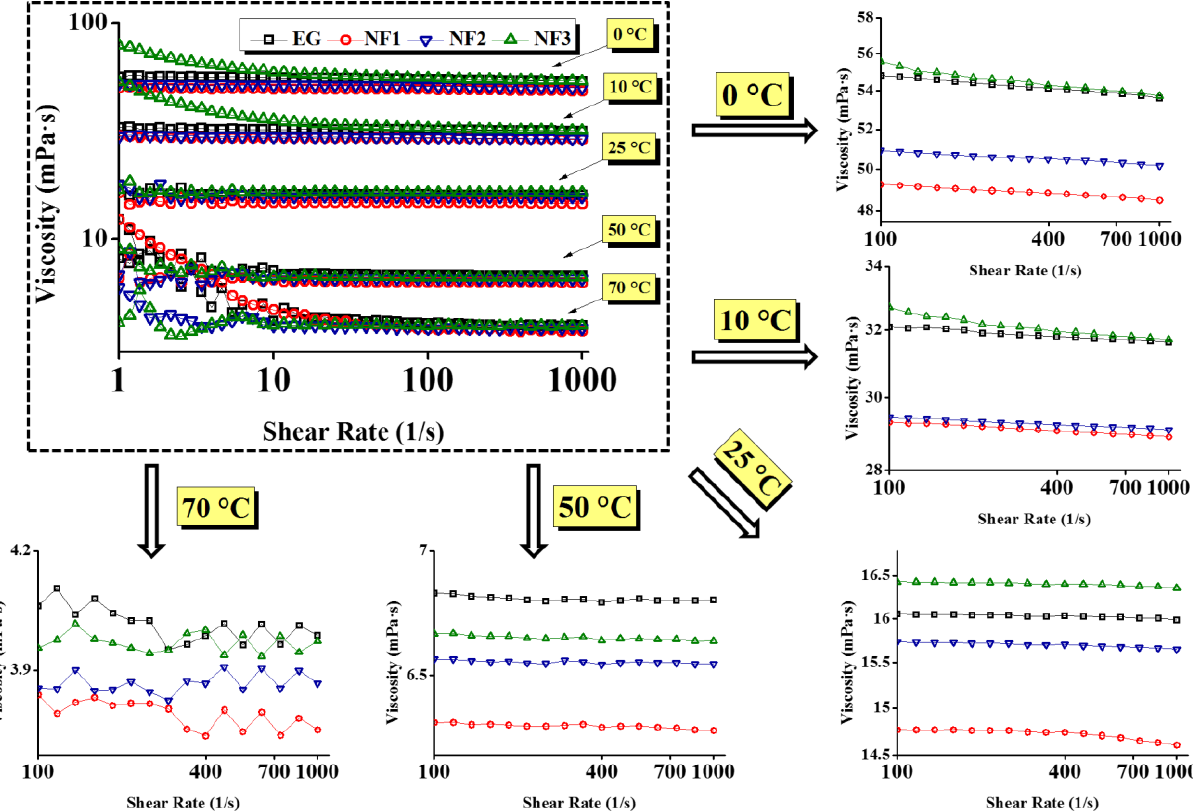
Figure 5. Apparent dynamic viscosity curves as a function of shear rate at various concentrations (NF1 — 0.005%; NF2 — 0.0075%, and NF3 — 0.01%) and steady-state temperatures (0 – 70 °C).